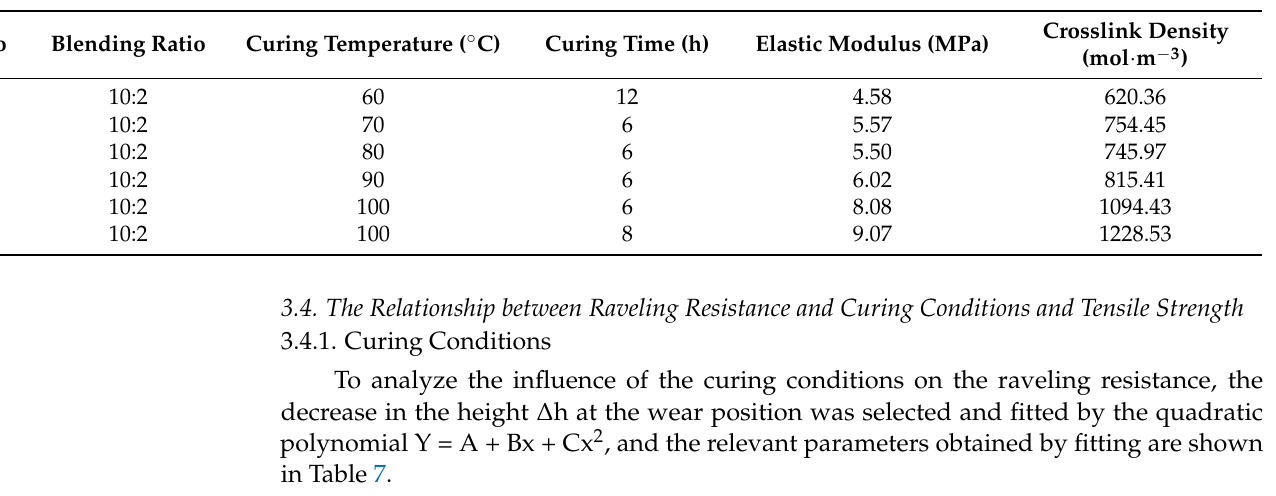
Figure 6. The relationship between tensile load and deformation of polyurethane under different curing conditions. ( a ) 60 °C & 12 h; ( b ) 90 °C & 6 h Table 6. Different elastic modulus and crosslink density under different conditions.